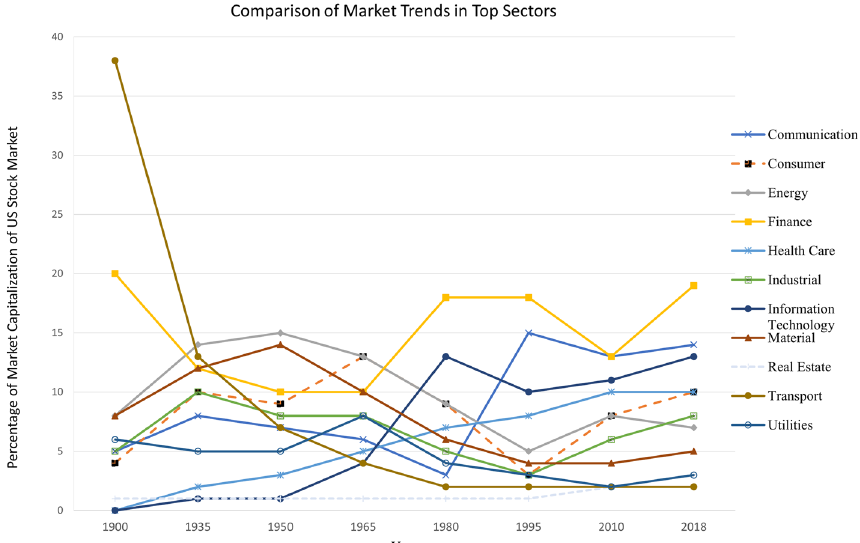
Fig. 8 Comparison of stock market capitalization from 1900 to 2018. The y -axis shows the total percentage of market valuation of top